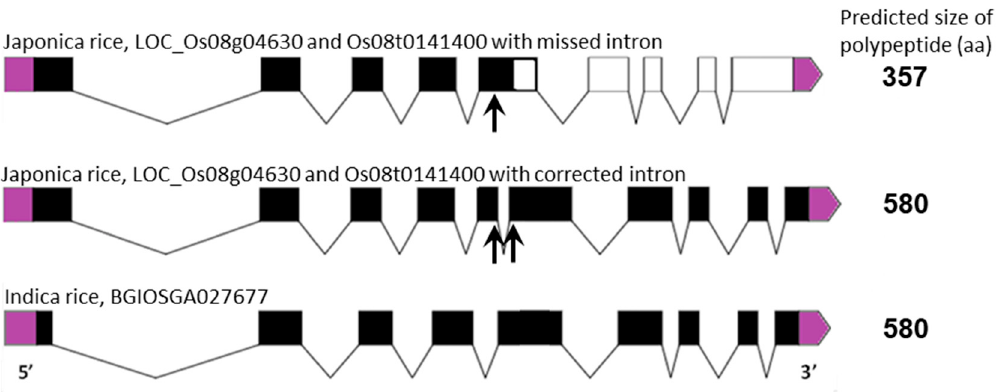
Figure 2. Identification of an additional intron in the sequence of OsNDB3 , japonica rice, which encodes a predicted OsNDB3 polypeptide of 580 aa, correcting the annotated size of 357 aa. A schematic presentation of the OsNDB3 gene structures in both japonica and indica rice with the missing or corrected intron. Exons are shown as black boxes or as clear boxes after the premature stop-codon of the missed intron. Start-codons on 5 ′ -end and stop-codons on 3 ′ -end are shown in purple. The predicted sizes of the polypeptides are